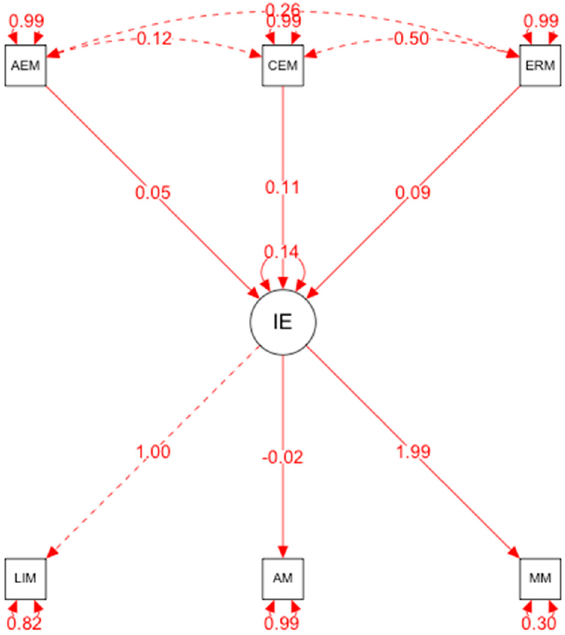
Figure 1. Structural equational modeling: AEM: emotional attention; CEM: emotional clarity; ERM: emotional regulation; IE: emotional intelligence; LIM: leadership; AM: anxiety; MM: